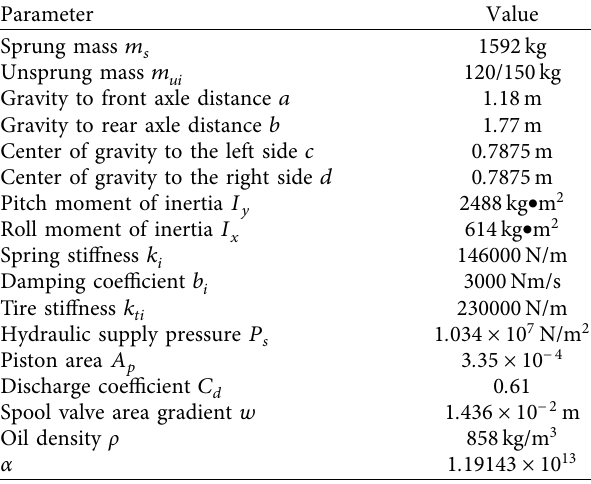
Table 1: Suspension model parameters.